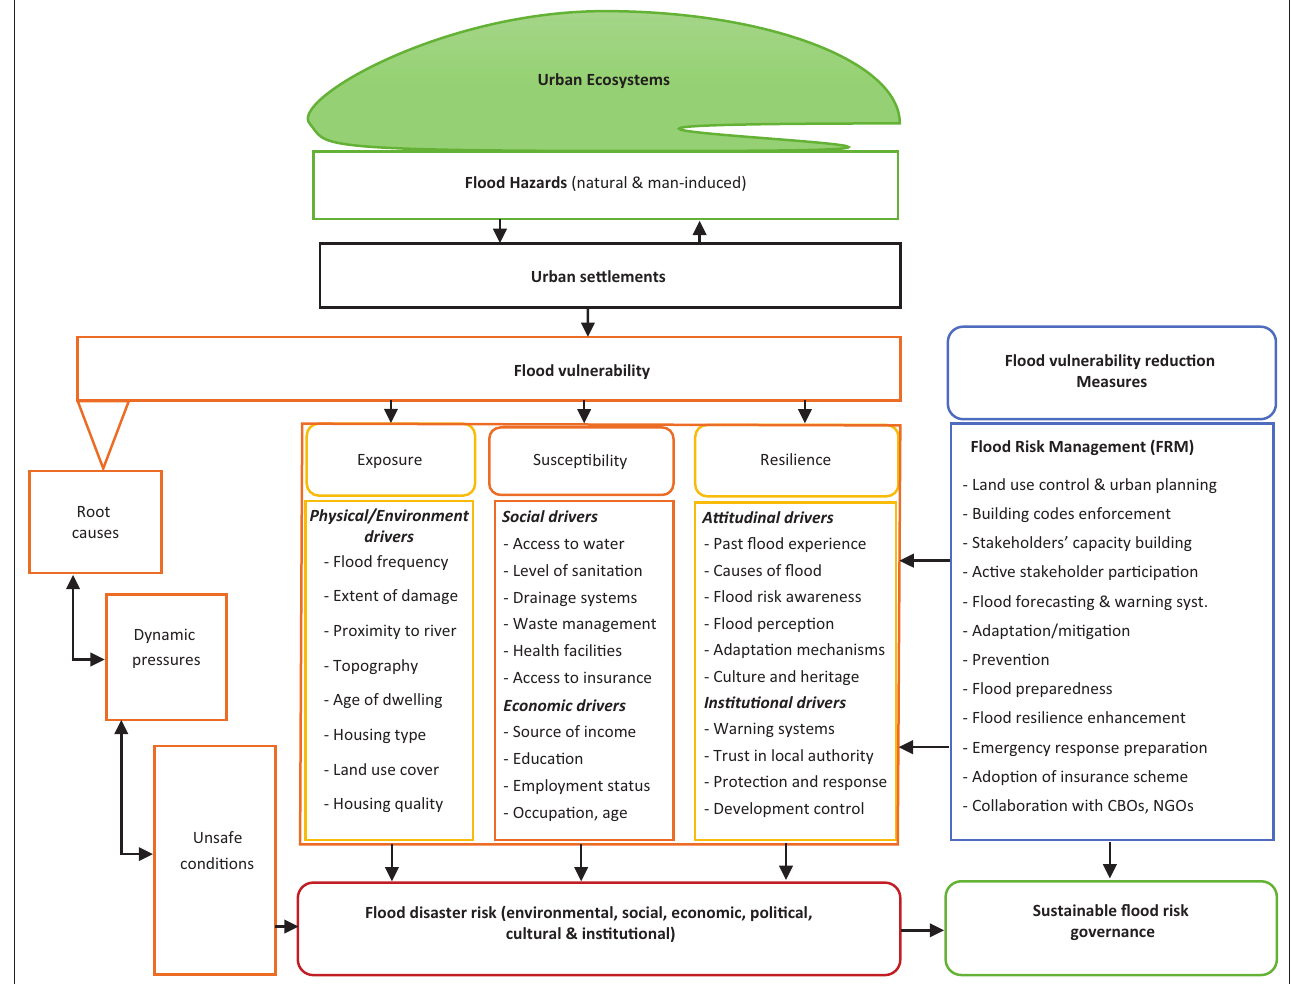
FIGURE 3: Proposed analytical vulnerability assessment framework for Ibadan